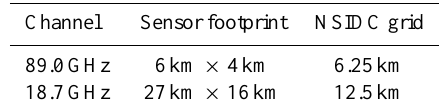
Table 1. Specifications of used channels from the AMSR-E